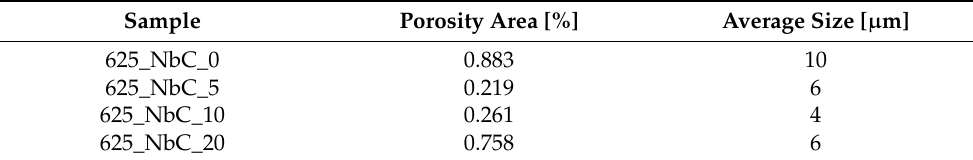
Figure 4. Microstructure of sample ( a )—Pure Inconel 625 (reference sample), ( b )—5% NbC, ( c )—10% NbC, ( d )—20% NbC reinforced Inconel 625 metal matrix after the hot-rolling. Scale applies to each micrograph. Table 4. Porosity estimations for obtained Inconel 625-NbC materials.